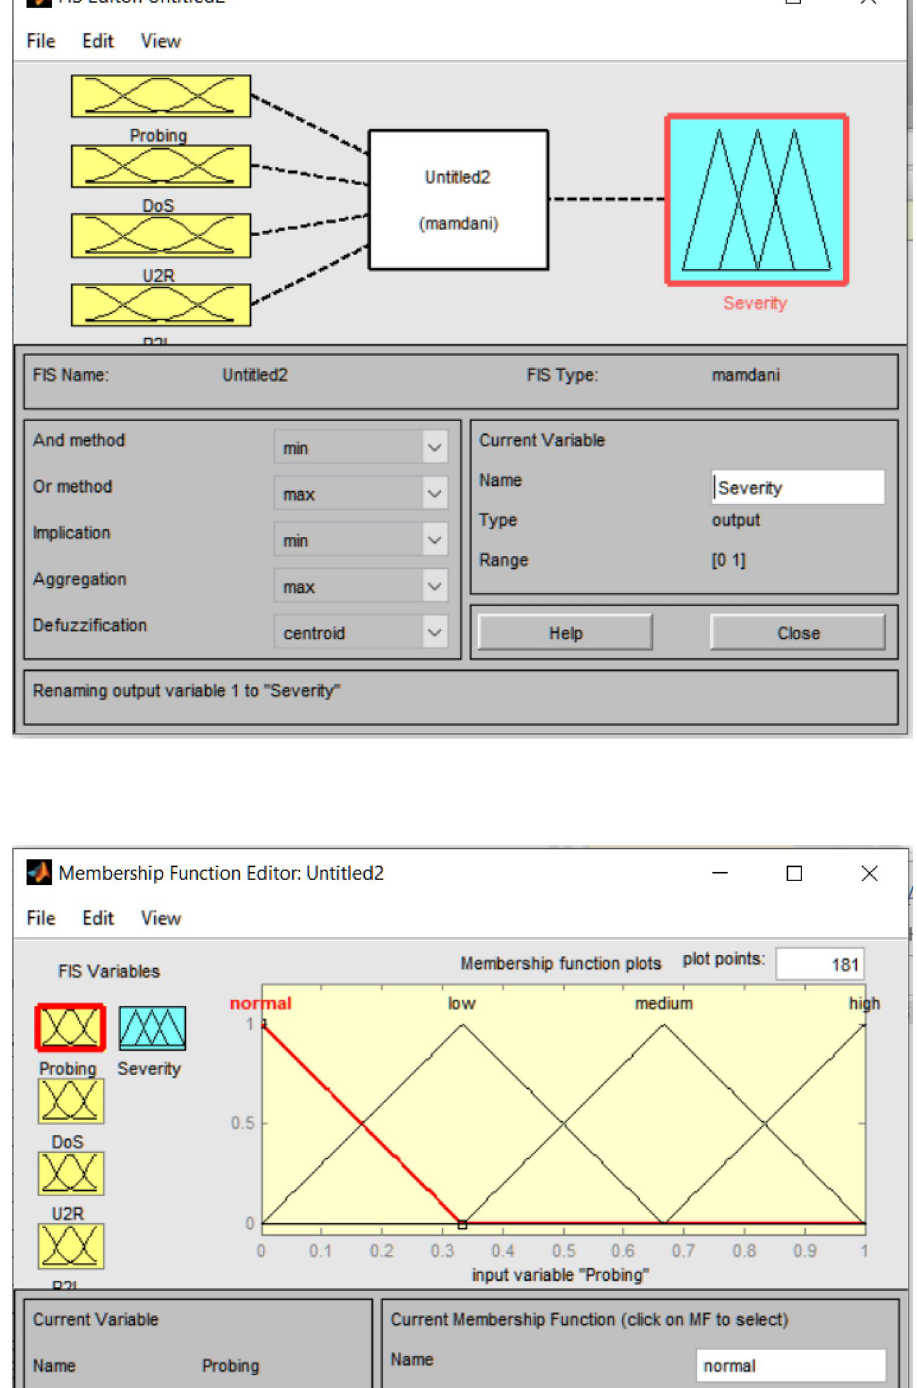
Fig. 6 Fuzzy inference system